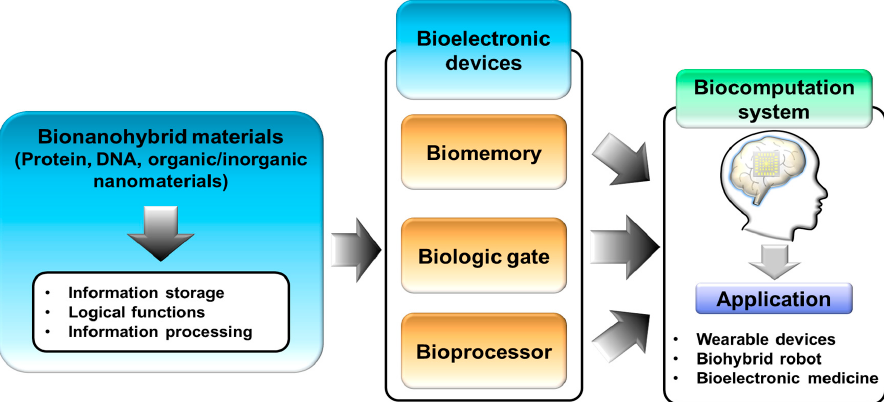
Figure 1. Bioelectronic devices based on bionanohybrid materials to develop biomemory, biologic gates, and bioprocessors for biocomputation systems.